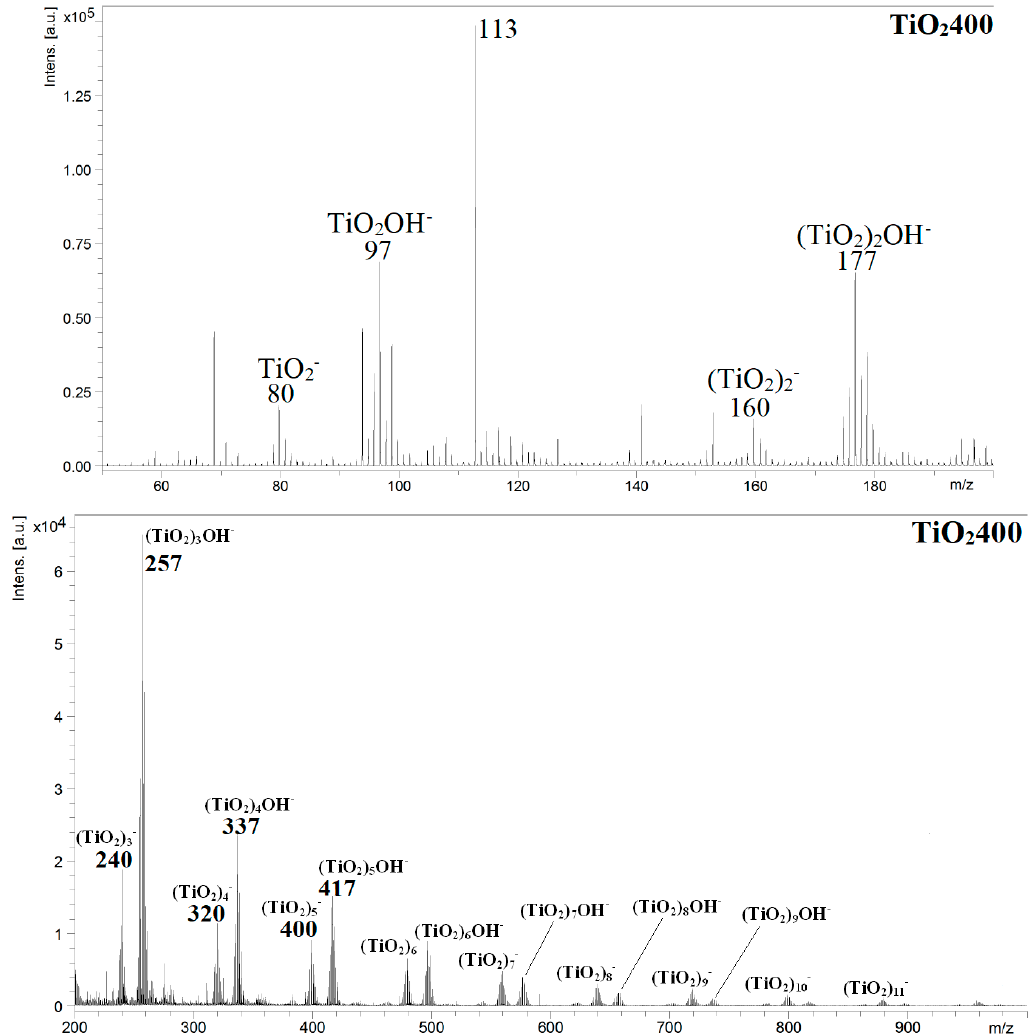
Figure 2. LDI mass spectra of TiO 2 400 obtained in the negative ion mode, in the m / z range 50–200 and 200–1000.